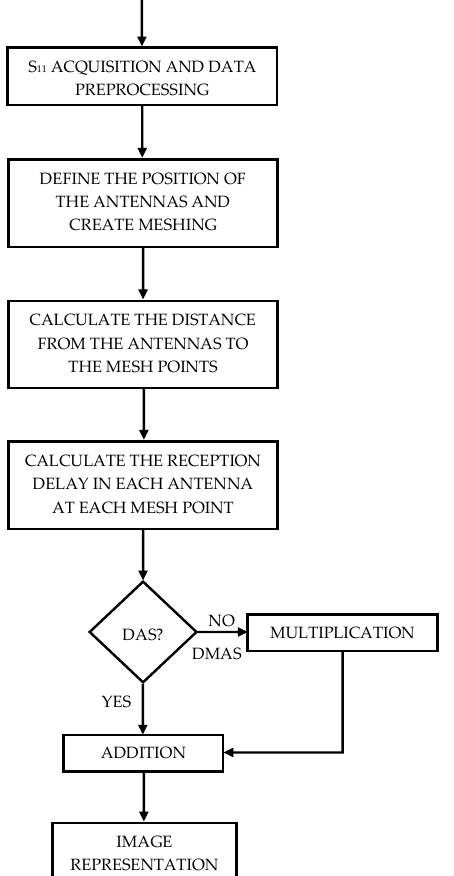
Figure 11. Flowchart for the imaging algorithm applied after each measurement.